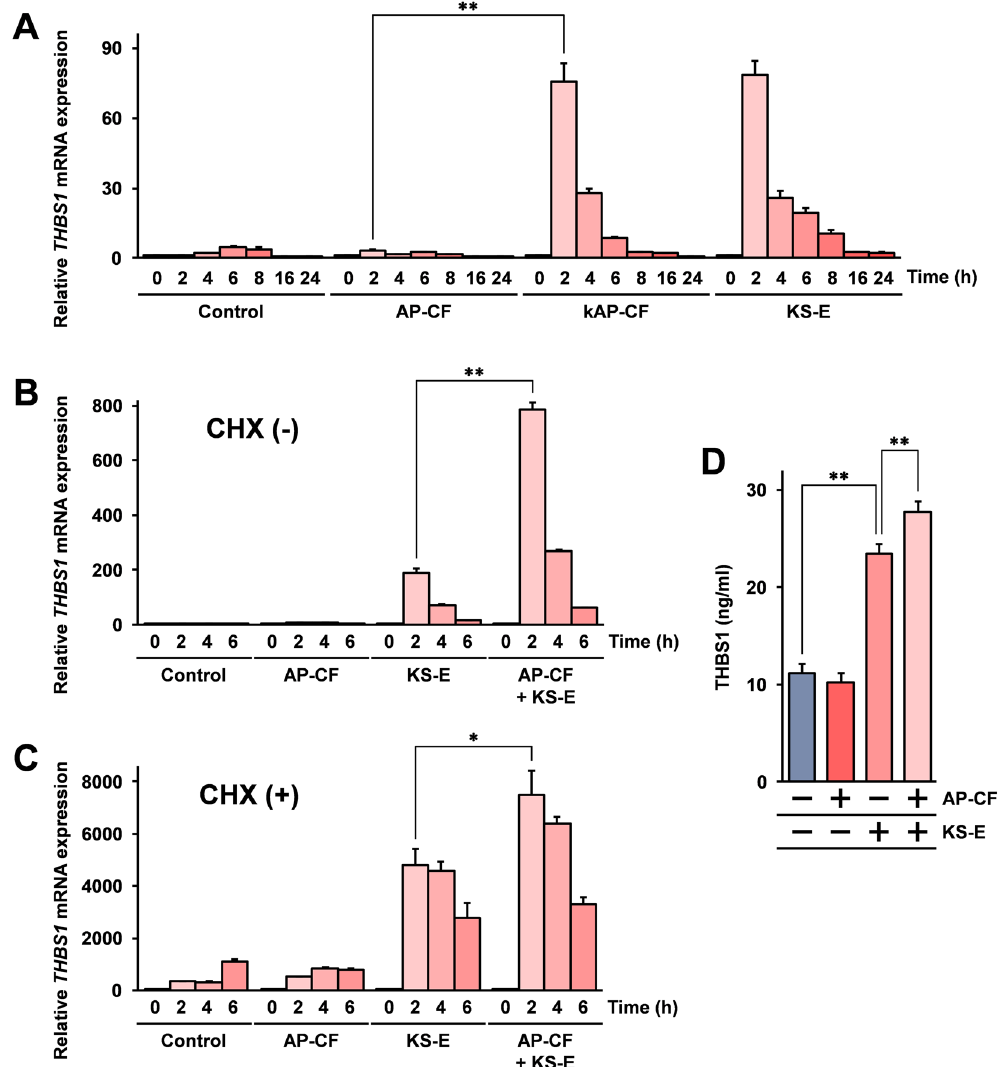
Figure 1. Aureobasidium pullulans -cultured fluid (AP-CF) enhances Thrombospondin-1 (THBS1) expression after stimulation with hot water extracts of Kurosengoku soybeans (KS-E). ( A ) Mono Mac 6 cells were stimulated with AP-CF or AP-CF made with ground powder of Kurosengoku soybeans (kAP-CF) as a nitrogen source, at the concentration of 100 μ g/ml β -glucan, or the cells were stimulated with KS-E at 20-fold dilution. ( B , C ) Mono Mac 6 cells were treated with or without 5 mM cycloheximide (CHX) for 30 min. Subsequently, the cells were stimulated with KS-E at 20-fold dilution together with AP-CF at the concentration of 100 μ g/ml β -glucan. After the incubation period indicated in the figure, the cells were harvested, and the THBS1 mRNA expressions were measured using the real-time RT-PCR method. The data are represented as relative values compared with the mRNA expression at the 0-hour time point after the normalization with glyceraldehyde 3-phosphate dehydrogenase (GAPDH) mRNA expression. Error bars indicate standard deviations calculated by three independent experiments. ( D ) Mono Mac 6 cells were stimulated with KS-E at 20-fold dilution together with AP-CF at the concentration of 100 μ g/ml β -glucan. After 24 hours, concentrations of THBS1 in the supernatant of a cultured medium of the cells were measured by ELISA. Error bars indicate standard deviations calculated by three independent experiments. The asterisk ( * ) and double asterisks ( ** ) indicate p < 0.05 and p < 0.01